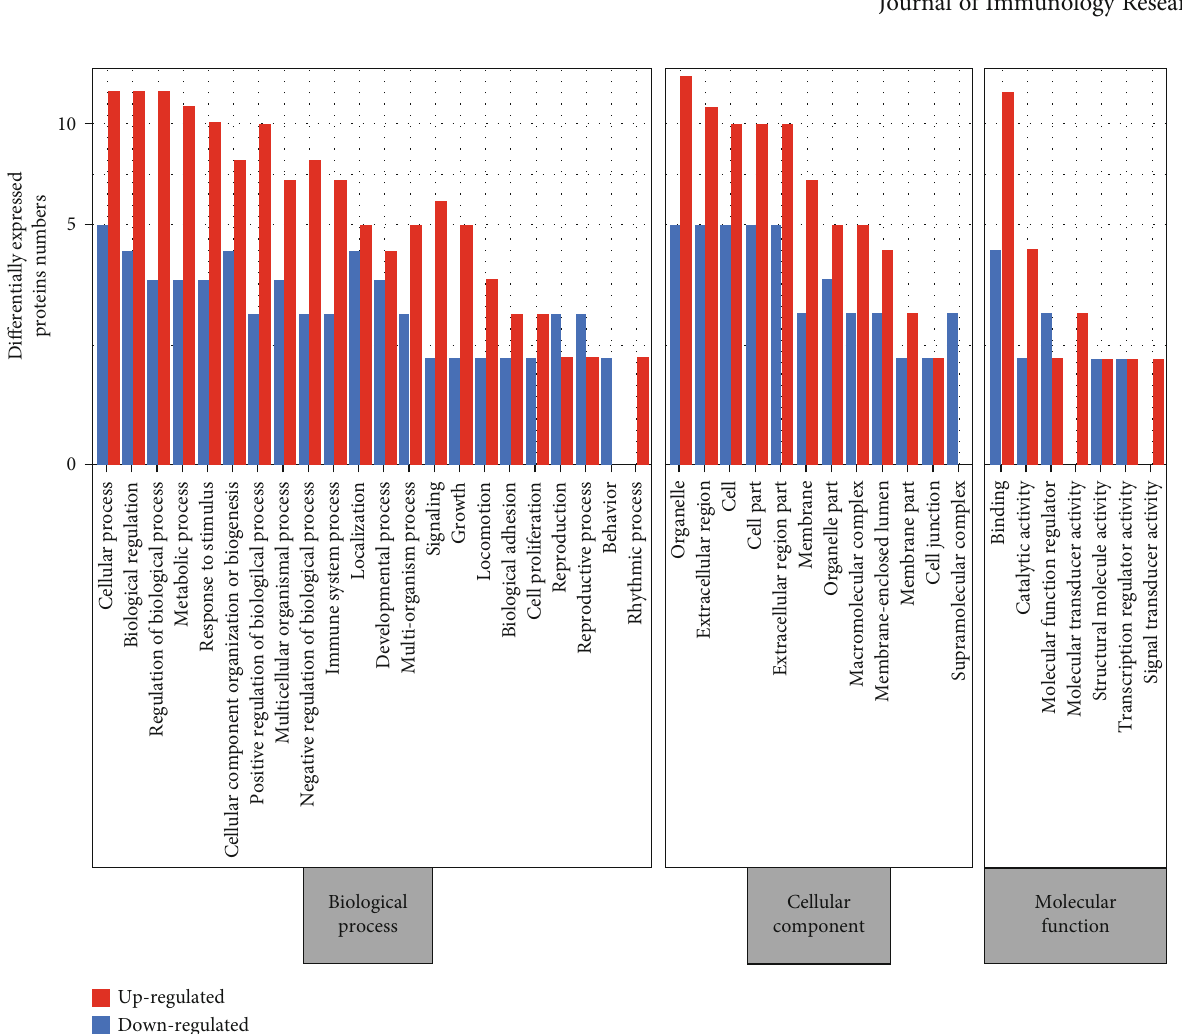
Figure 2: Gene ontology functional classi fi cation of plasma-derived exosomes in rheumatoid